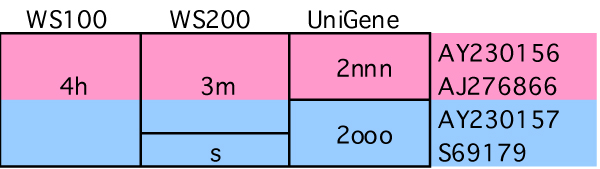
Cluster 4h. Distribution of the four mRNA sequences of WS100 Cluster 4h. Shaded colors represent mRNA sequences from the same gene as determined by alignment analysis and literature review.